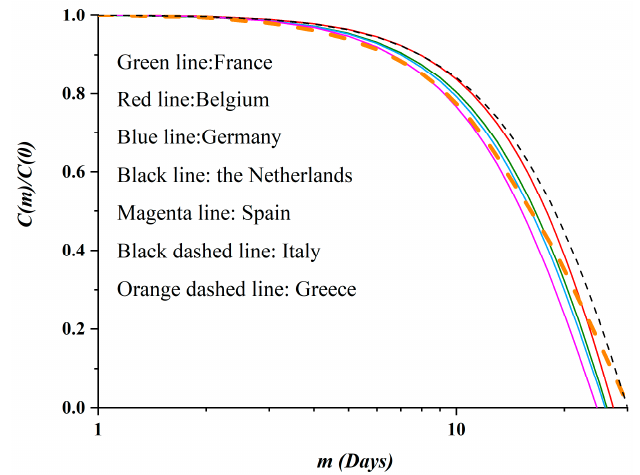
Figure 12. The normalized autocorrelation functions, as calculated by the epidemiological data; France is shown by the green line, Belgium by the red line, Germany by the blue line, the Netherlands by the black line, Spain with the green line, Italy by the black dashed line and Greece by the orange dashed line. Note that the plot corresponding to Greece intersects all the other plots, as in Figure 11.